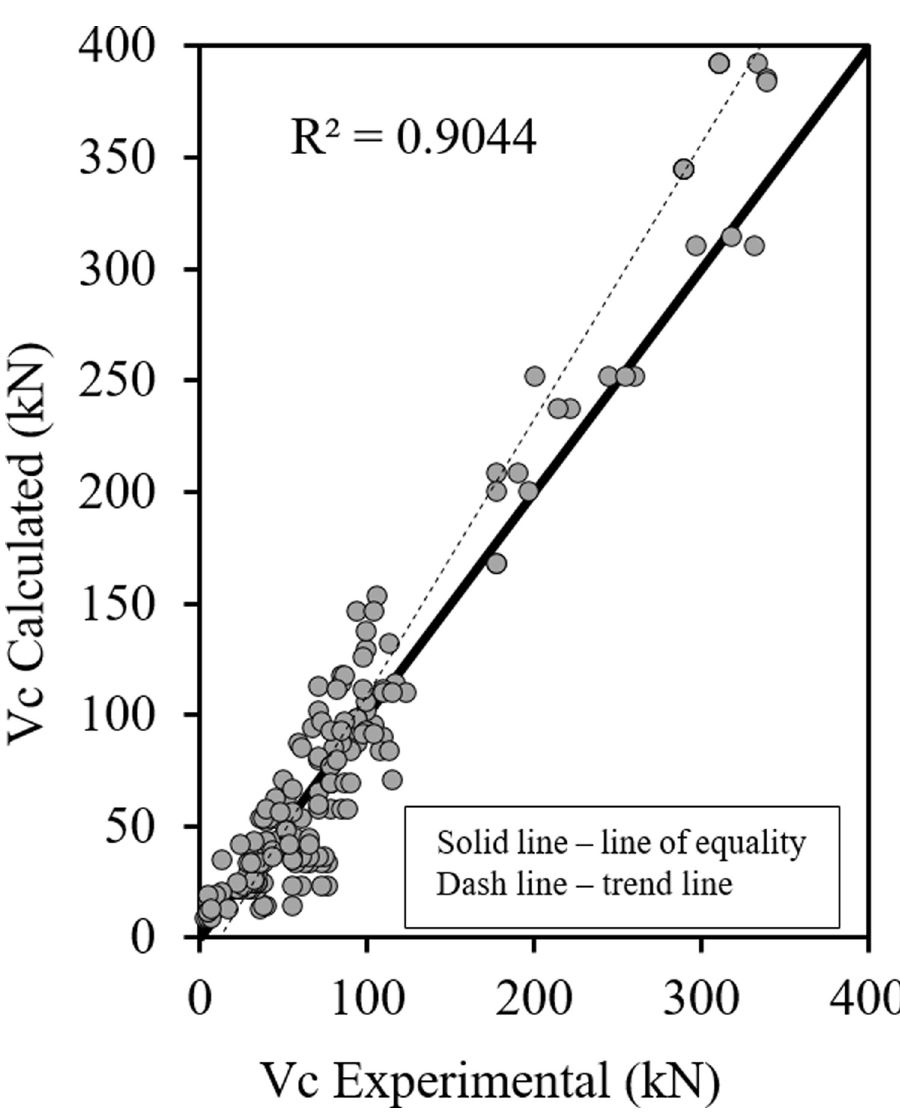
Fig 4. Shear strength of HSC beams (Eq